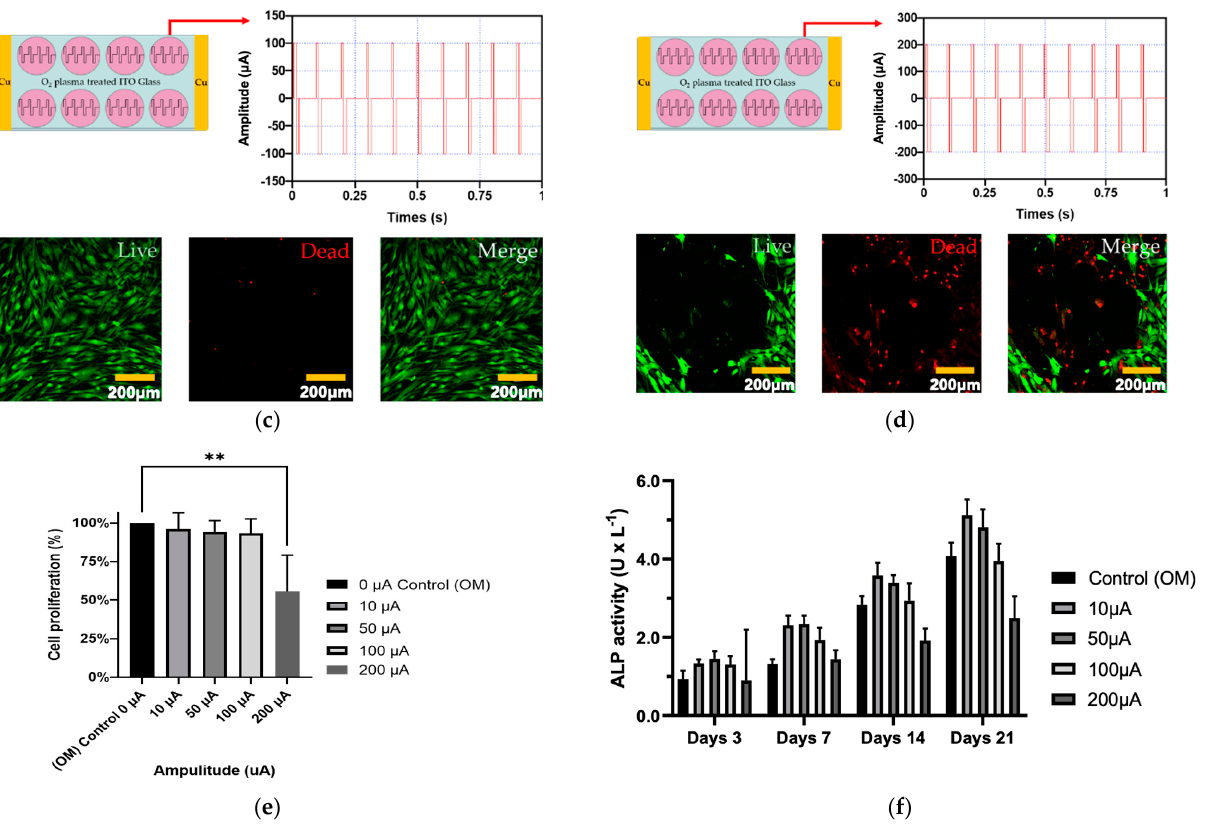
Figure 3. The cytotoxicity of electrical stimulation hADMSCs evaluated with the four different amplitude conditions (amplitude: ( a ) 10 µA, ( b ) 50 µA, ( c ) 100 µA, and ( d ) 200 µA and the frequency of all conditions was 10 Hz). In addition, the green fluorescence represents live cells and red fluorescence represents dead cells. ( e ) Cell proliferation of hADMSCs with electrical stimulation, ( f ) ALP activity assay of hADMSCs with electrical stimulation. These graph data were analyzed with one-way ANOVA (error bars represent the standard deviation (SD, ** p < 0.01). Finally, graph ( e ) was performed with Tukey’s HSD post-hoc